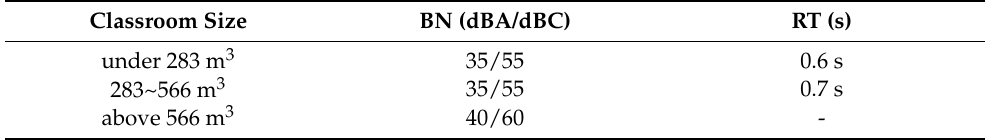
Table 1. The acoustic performance standard for the classroom in the US (unoccupied). Classroom